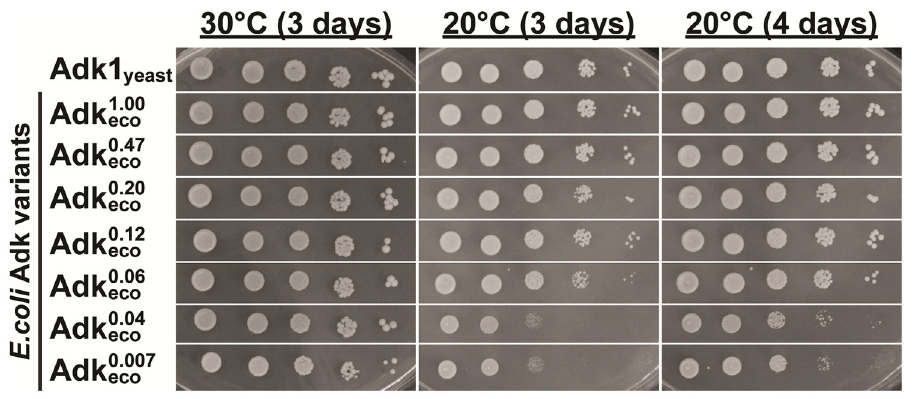
Fig 7. Serial dilution growth assays at 30°C and 20°C. Yeast adk1 Δ cells expressing Adk1 yeast or indicated variants of Adk eco proteins were serially diluted, spotted on SC-Leu plates, and incubated at 30°C and 20°C for 3 – 4